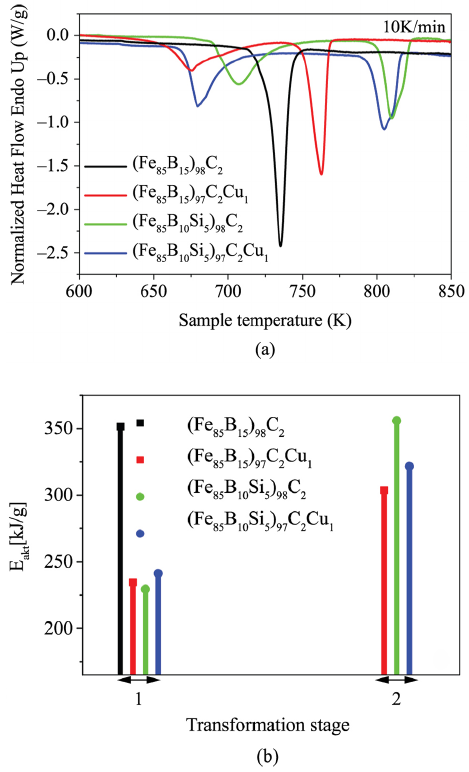
Figure 1. (a) Temperature dependence of normalized heat flow measurement by DSC, for the systems with different chemical composition, inset shows the effect of separated additions in the base composition. (b) Activation energies for each transformation stage in studied systems determined by Kissinger method (DSC), accuracy of E determination is better than +/– 5 kJ/mol. akt